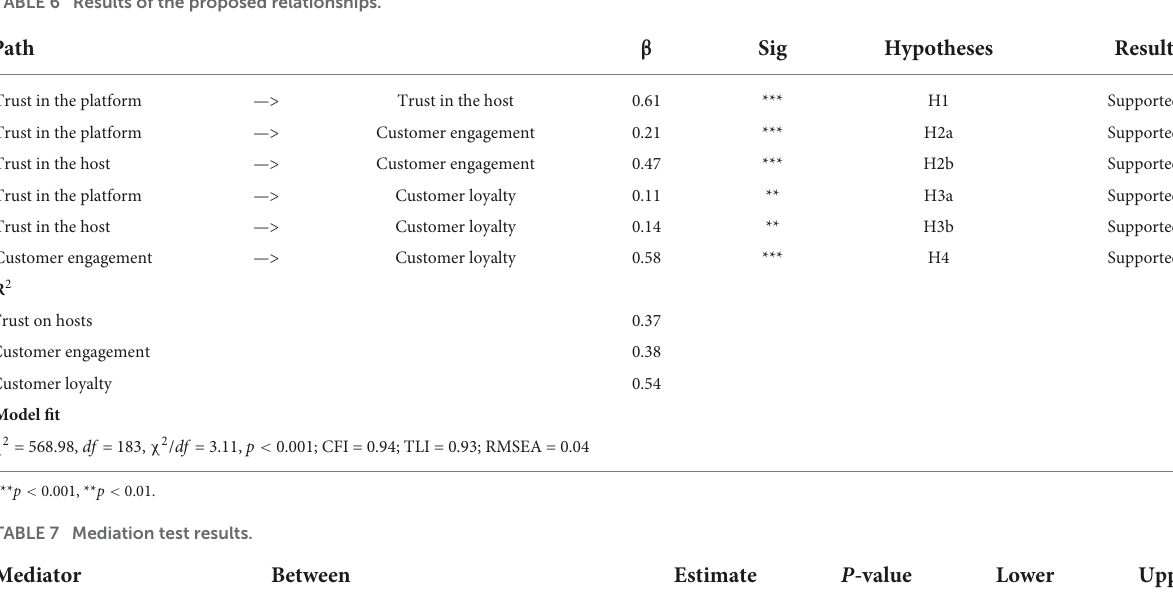
TABLE 6 Results of the proposed relationships.